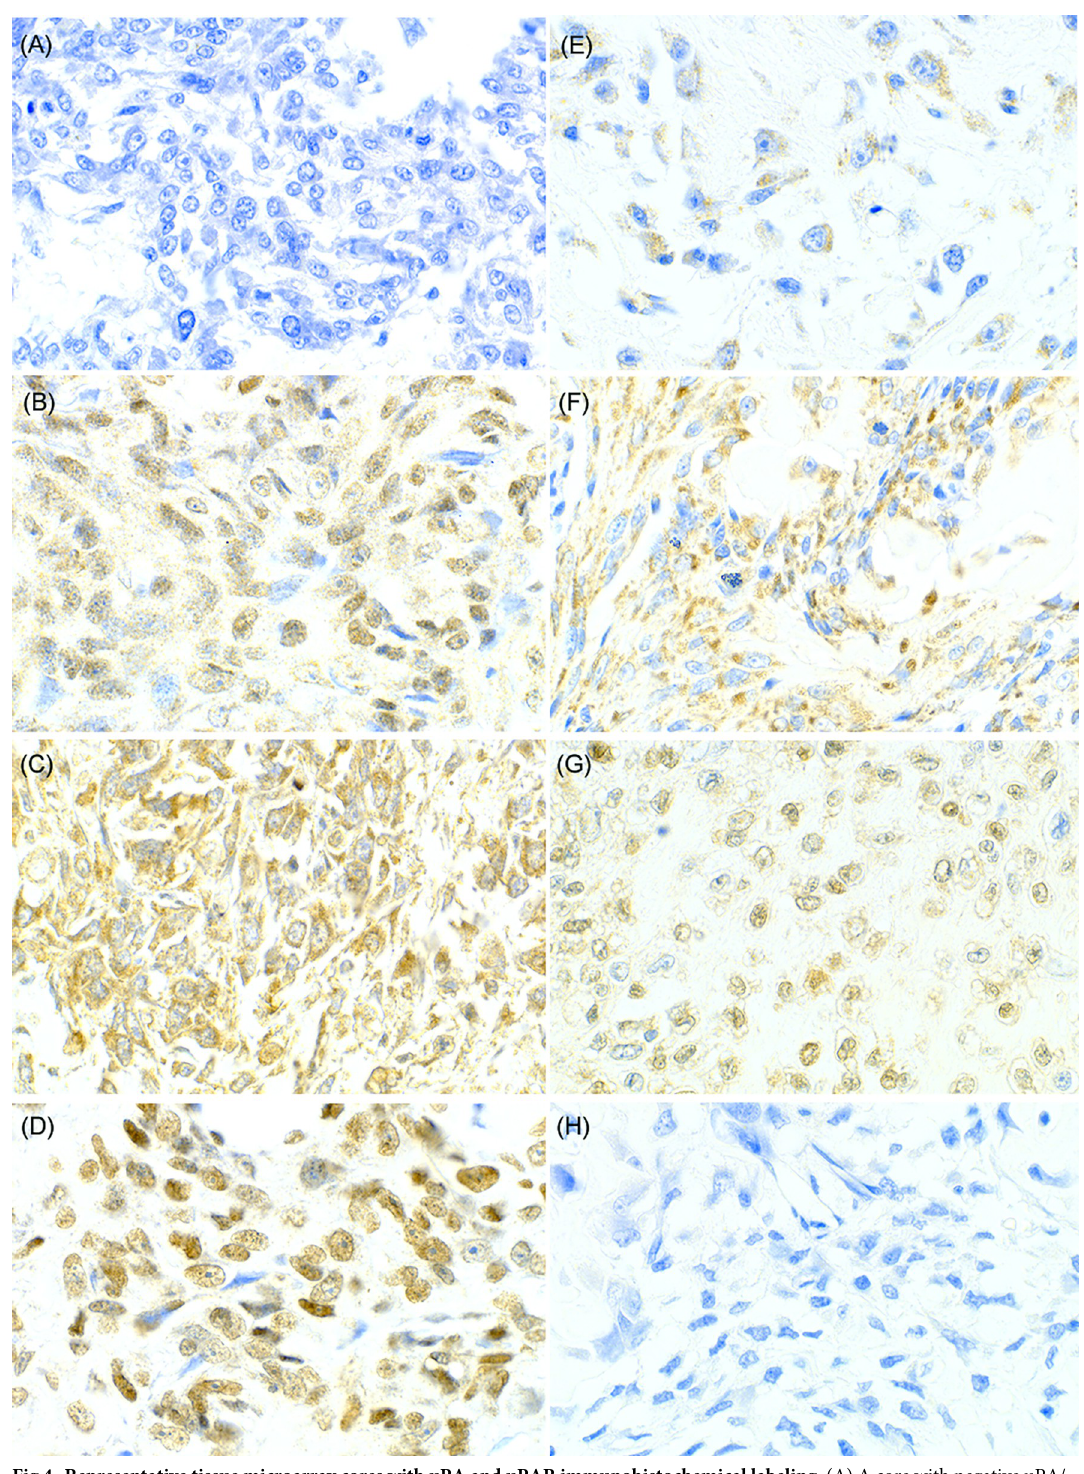
Fig 4. Representative tissue microarray cores with uPA and uPAR immunohistochemical labeling. (A) A core with negative uPA/ uPAR expression. Osteosarcoma cells had clear cytoplasm and nuclei with no immunoreactivity. (B) Diffuse and weak cytoplasmic uPA expression (1+) is seen in majority of the osteosarcoma cells with nuclear positivity. (C) Osteosarcoma cells diffusely showed strong cytoplasmic uPA expression (2+) throughout the core with nuclear positivity. (D) Strong distinct nuclear uPA expression is present with weak cytoplasmic labeling (1+). (E) Weak to moderate uPAR expression (1+) is present in cytoplasm of the osteosarcoma